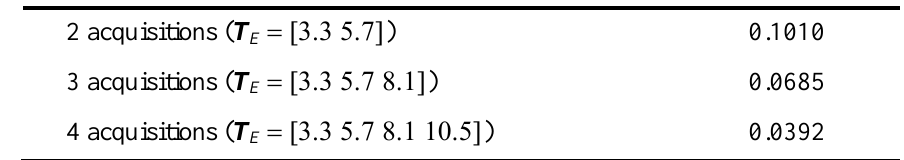
Table 2. Normalized mean square error for different number of available acquisitions— air/tissue discontinuities field map case.